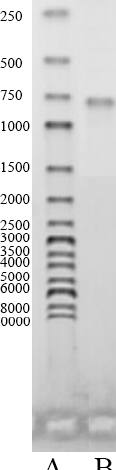
Figure 6. Results of the PCR analysis. A – Thermo Scientific O’GeneRuler 1 kb DNA Lad- der. B – PCR analysis of the B. pumilus 16 strain using Pum-f and Pum-r Table 1. Comparison of the biochemical and physiological characteristics of B. pumilus 16 and type strains